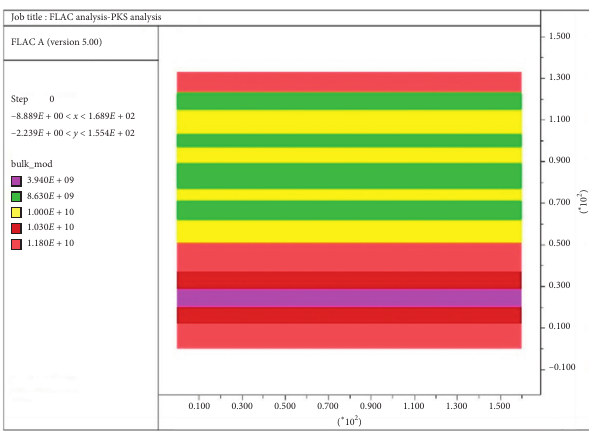
Figure 3: Numerical simulation model. Table 1: Actual measured ground